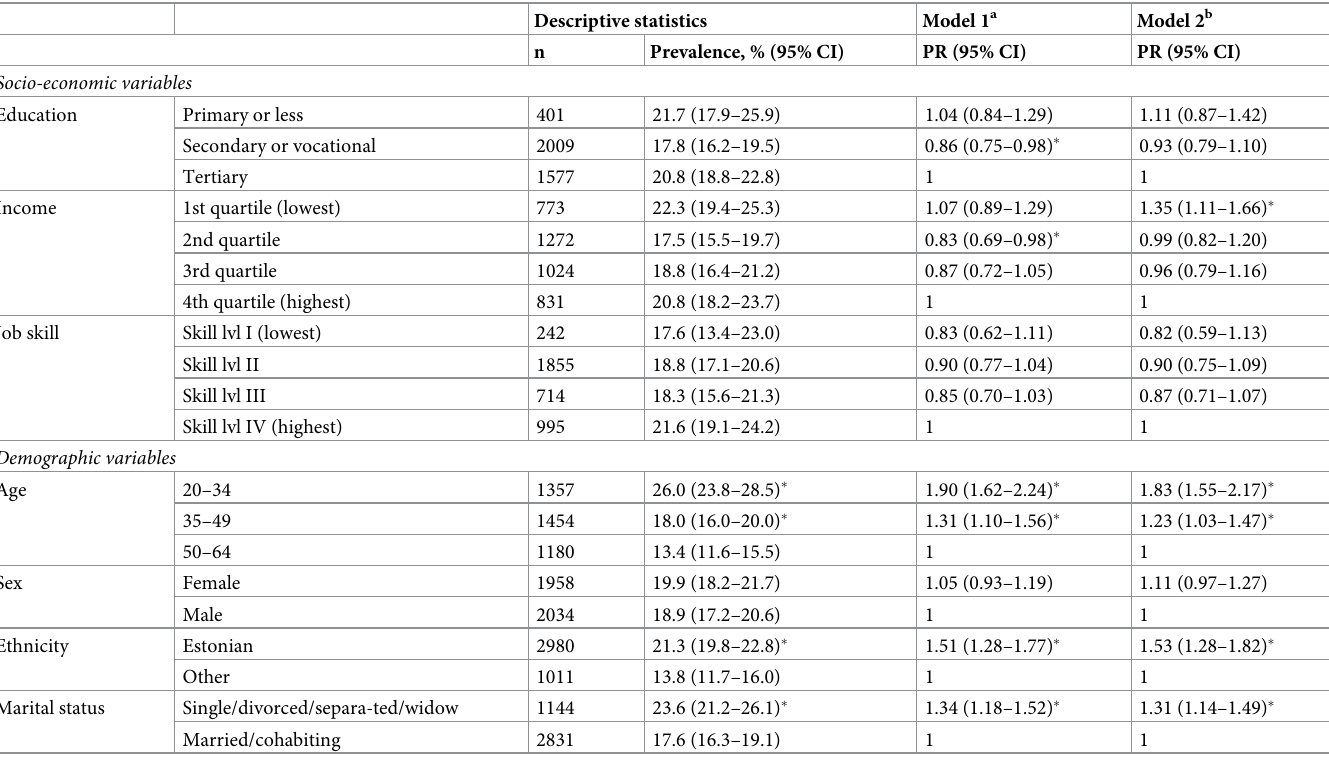
Table 1. Stress and association with socio-economic and demographic variables, descriptive statistics and prevalence ratios with 95%